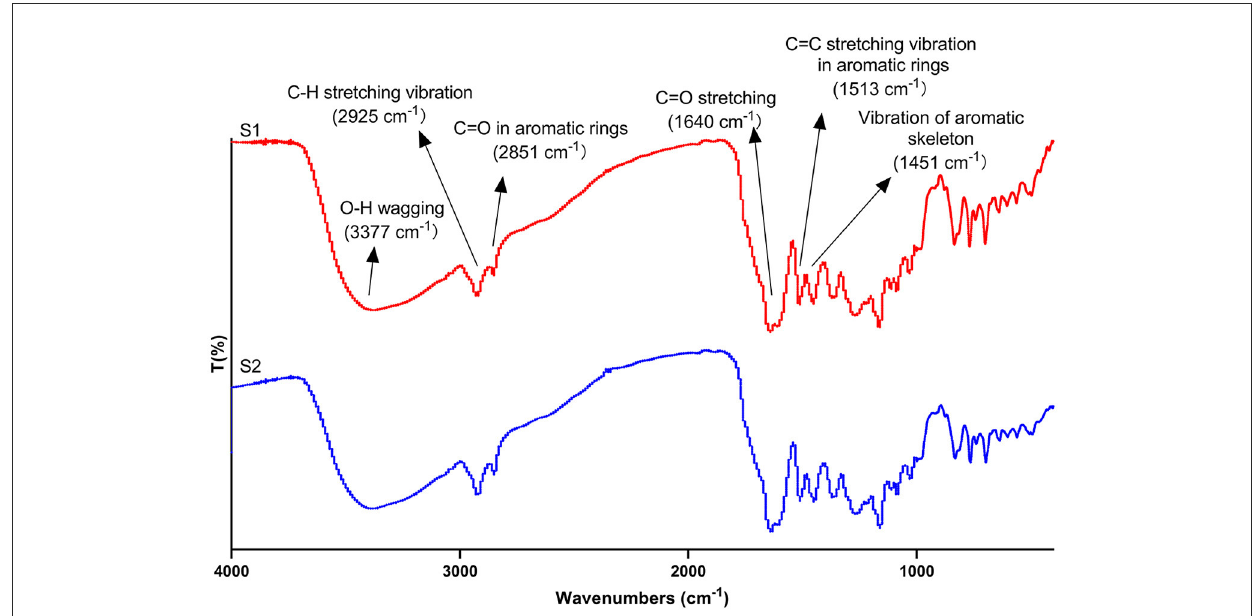
FIGURE7 Fourier transform infrared spectroscopy spectra of maceration extract (S1) and ultrasound extract